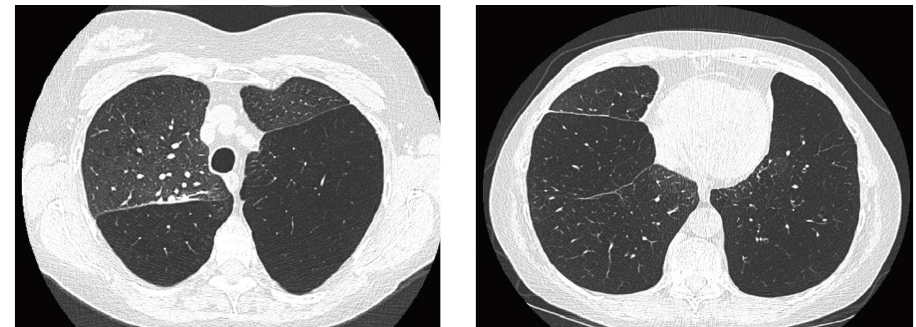
Figure 2: CT chest of upper and lower lobes showing panlobular emphysema with predominantly lower lobe involvement.